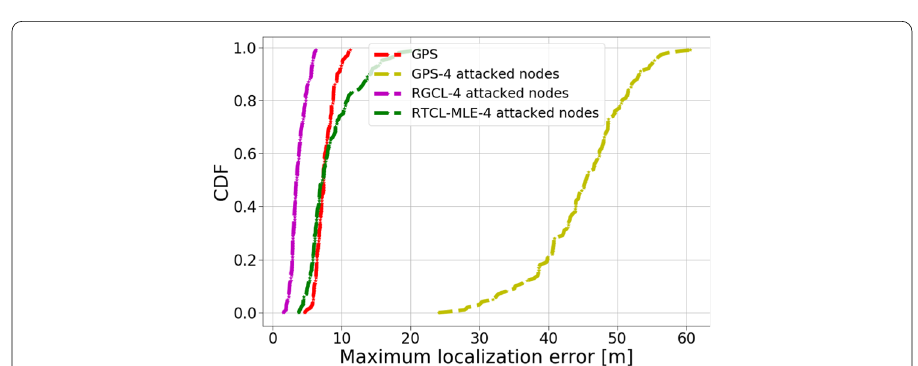
Fig. 12 CDFs for maximum localization error with 4 vehicles under GPS location spoofing